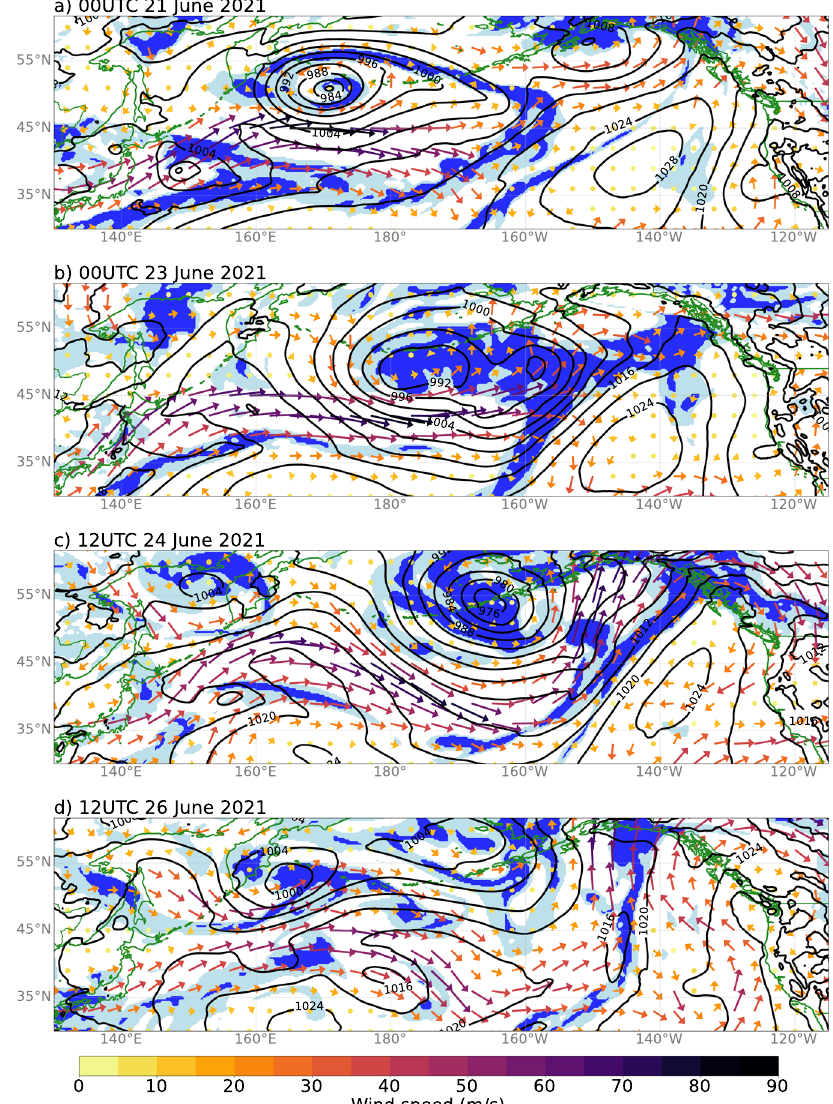
Fig.3|Meteorologicalconditionsleadinguptoheatwaveonset. Meteorological conditionsovertheNorthPaci fi cfor a 00UTC21June, b 00UTC23June, c 12UTC24 June, and d 12UTC 26 June. Data from ERA5 reanalysis showing: mean sea-level pressure(MSLP;contoured,hPa),700hParelativehumidity(RH;shaded,lightblue